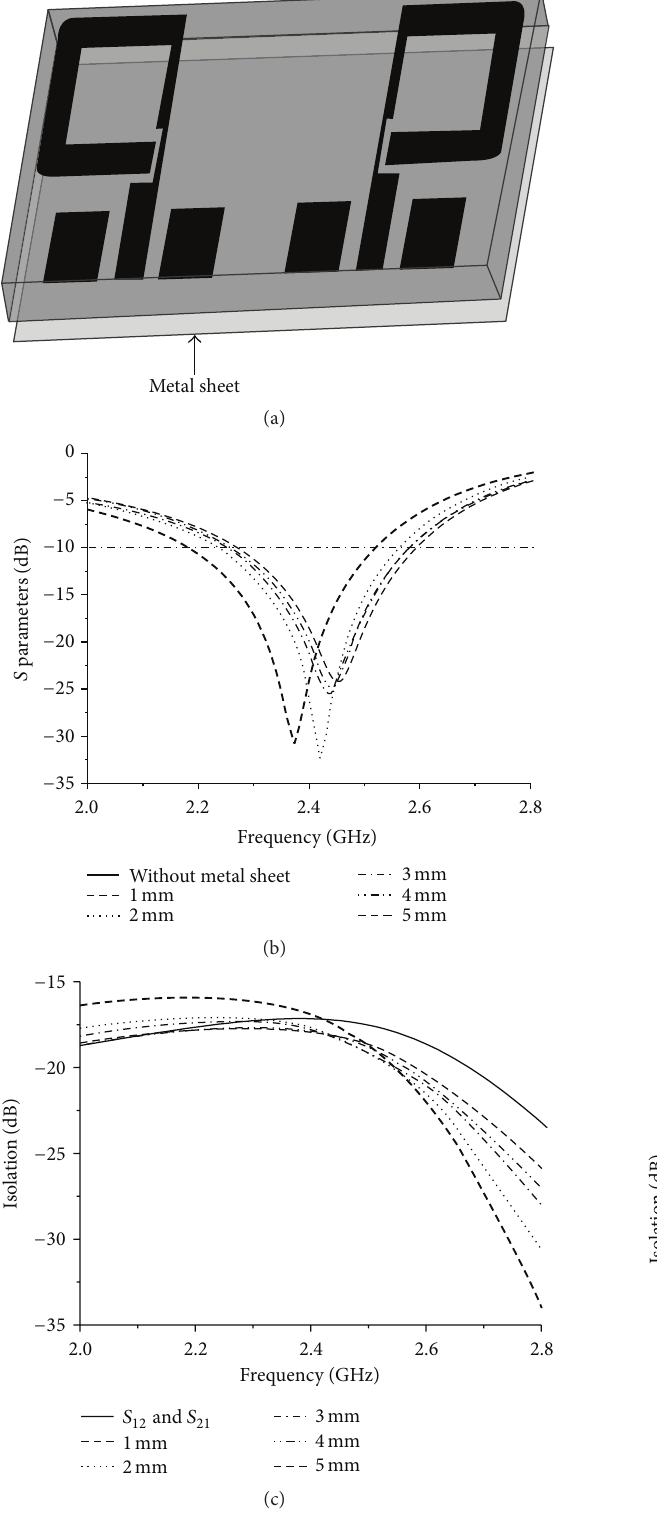
Figure 15: (a) Proposed MIMO antenna with a metal sheet sepa- rated by free space. (b) Reflection coefficients of the MIMO antenna systemwithametalsheet.(c)IsolationoftheMIMOantennasystem with a metal sheet.